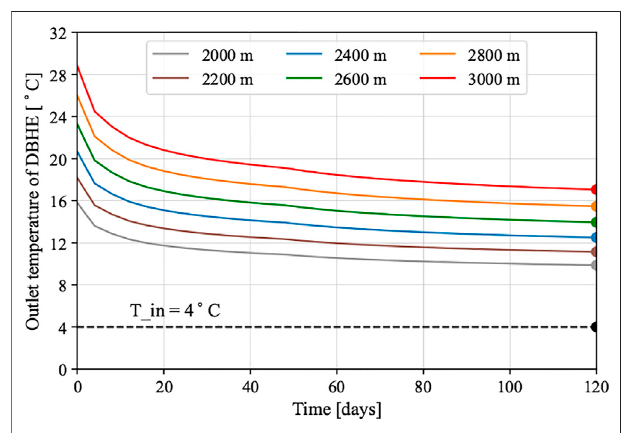
FIGURE3 | Thermal performancetest of heatextraction capacity for the DBHE with different drilling